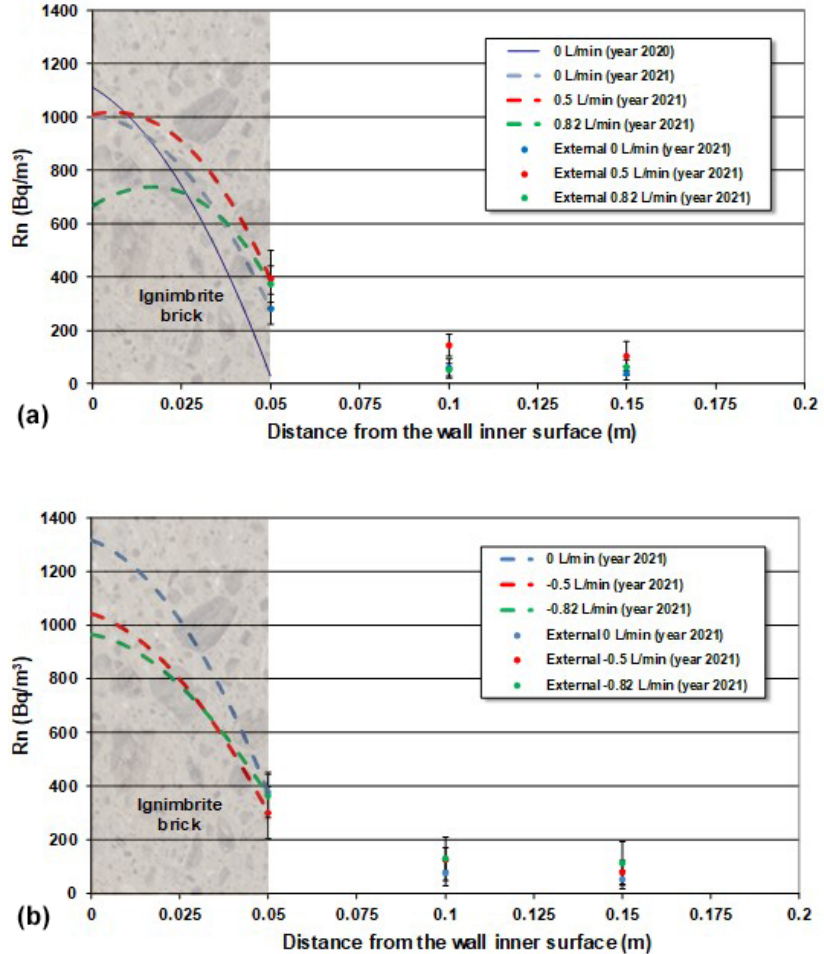
Figure 4. Radon diffusion through the wall of the scale model room according to Eq. (3). (a) Introduction of outdoor air in the model room at 0.5 and 0.82Lmin − 1 , compared with the no ventilation experiment. The curve at 0Lmin − 1 of year 2020 does not take into consideration the real measurements of laboratory background at increasing distances from the chamber walls, but just an average value of 30Bqm − 3 . (b) Extraction of indoor air from the model room at 0.5 and 0.82Lmin − 1 , compared with the no ventilation